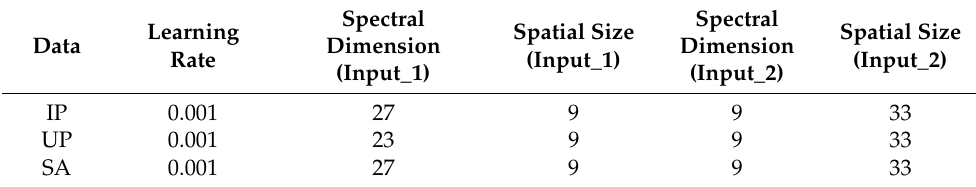
Table 4. All parameters for the three HSI datasets.